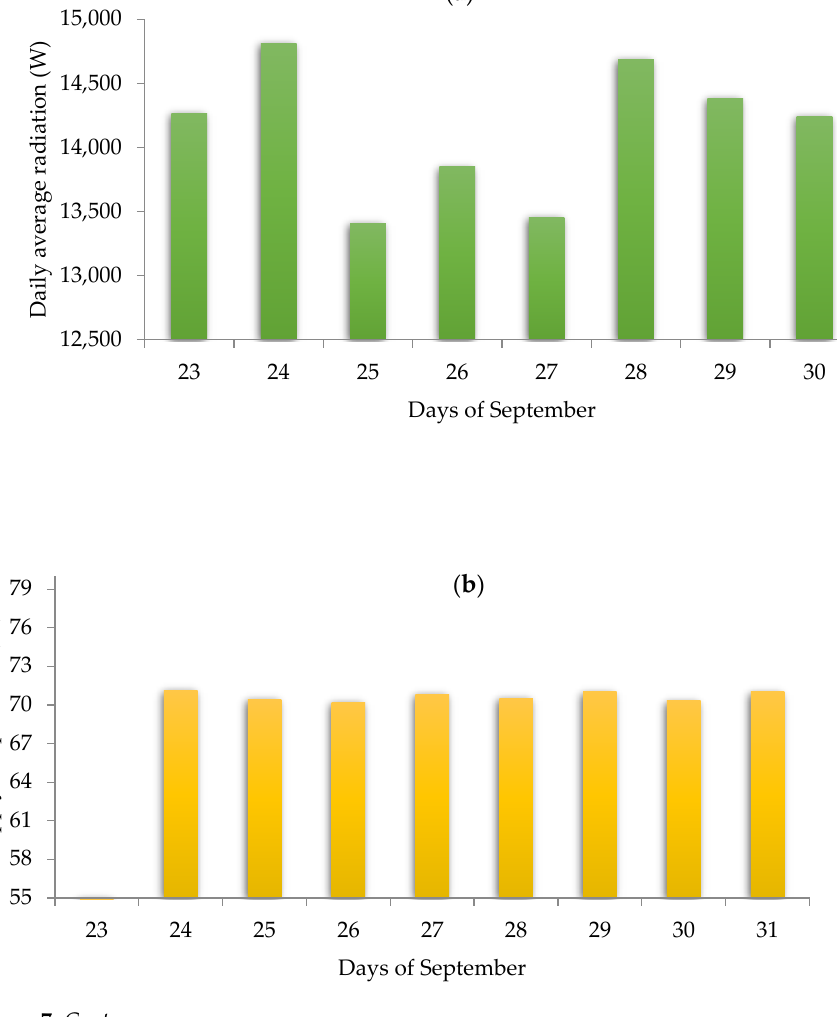
Figure 7 serves to better visualize the daily changes in mass flow and temperature.